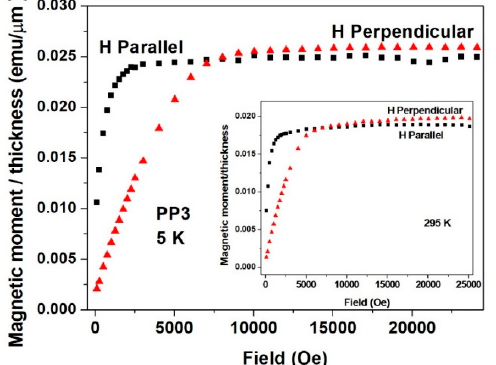
Figure 11. Isothermal magnetic moment plots measured at 5 K parallel (black symbols) and perpen- dicular (red symbols) to the plane of PP1 deposited quaternary Sn-Fe-Ni-Co alloy coatings. The inset shows the similar plots measured at 295 K.